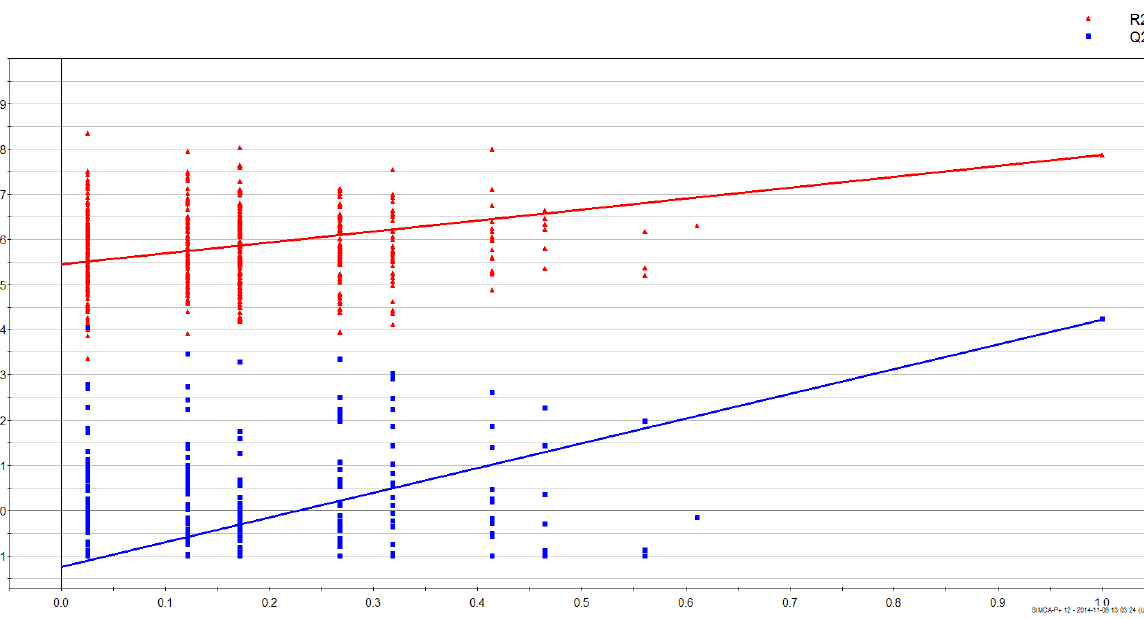
Figure 2. Results from response permutation test of gender (male vs. female) samples. The vertical axis gives the R2 (red) and Q2 (blue)-values of the original model (far to the right) and the Y-permuted models further to the left. The horizontal axis shows the correlation between the permuted y-vectors and the original y-vector for the selected